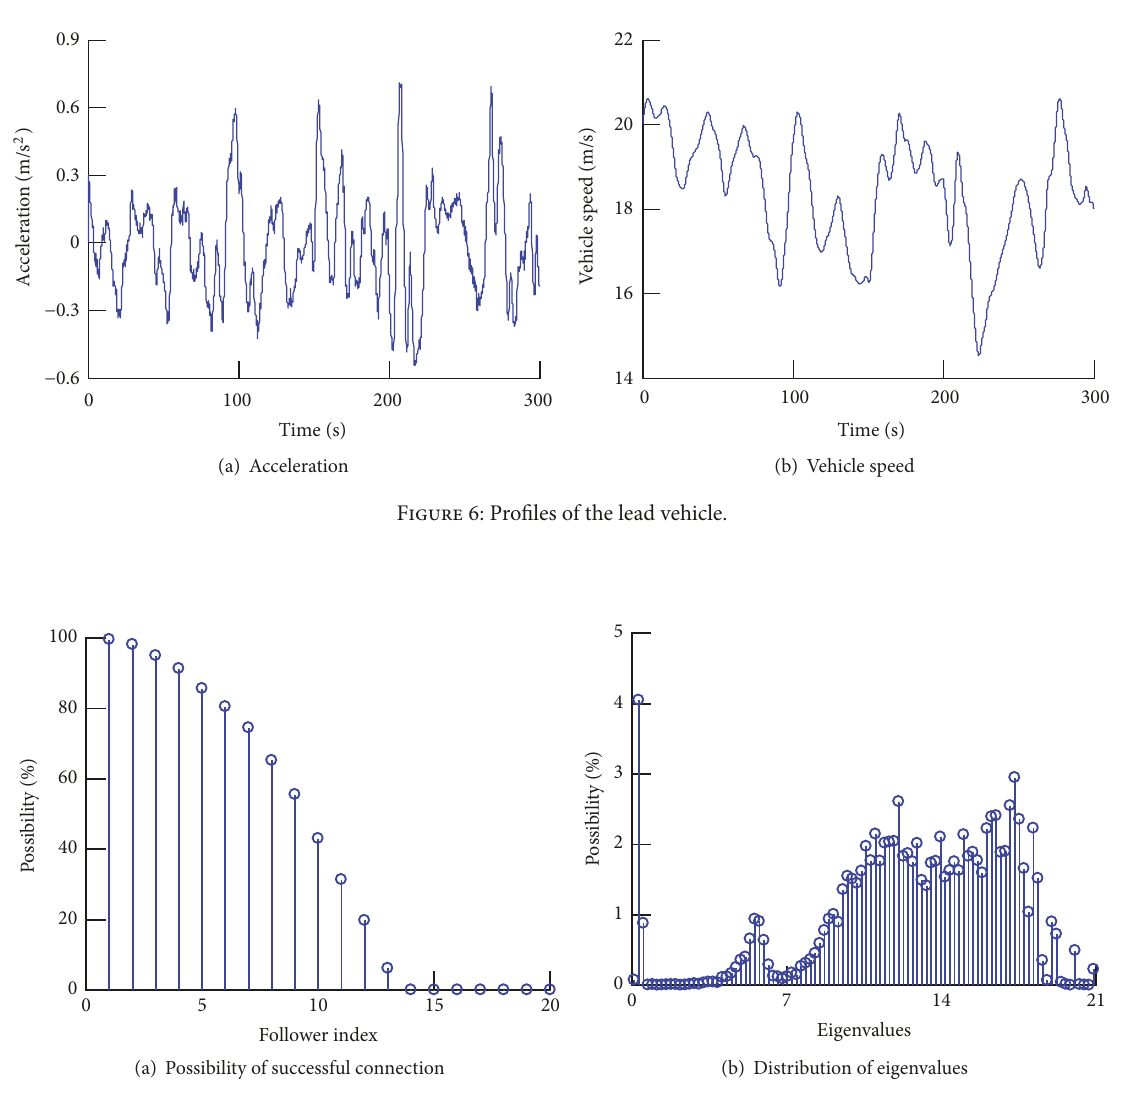
Figure 7: Statistical results of